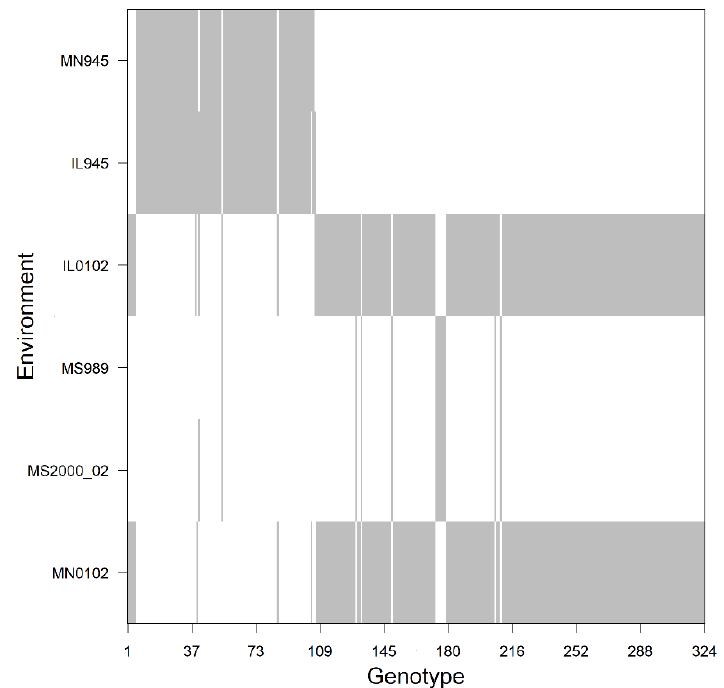
Figure 1. Graphical representation of the allocation of genotypes ( x -axis) in environments ( y -axis) of 324 soybean genotypes selected from the USDA soybean collection observed in 6 environments. Vertical gray lines represent the genotypes-in-environments combinations that were observed while the white lines correspond to unobserved combinations. The information of the observed combinations (vertical gray lines) is used for stablishing training-testing partitions.